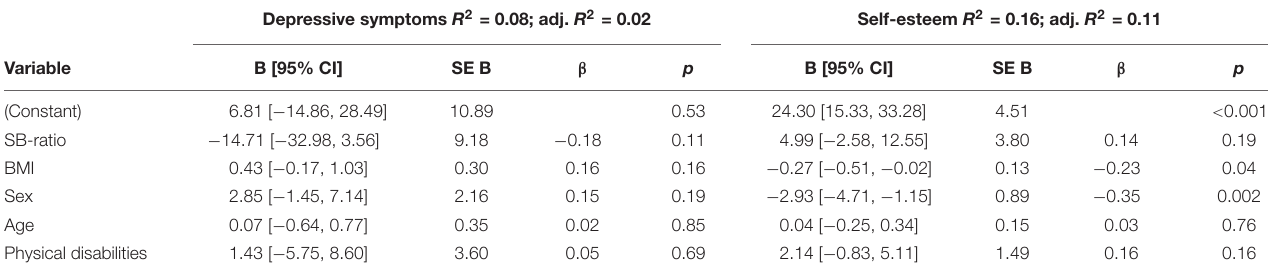
TABLE 6 | Regression analyses of SB ratio on depressive symptoms and